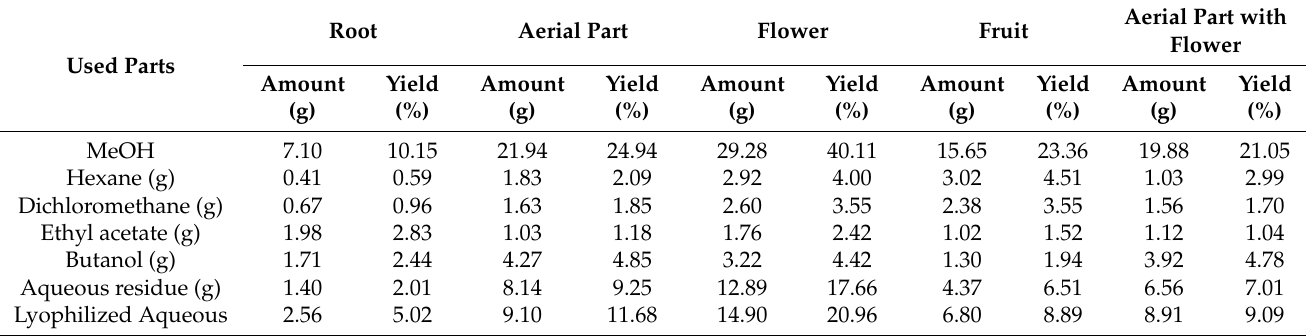
Table 1. The amounts (g) and yields (%) of the extracts and sub-extracts from different parts of Hypericum scabrum .